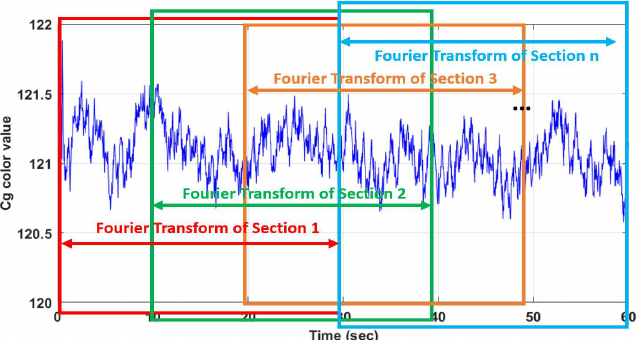
Figure 12. Separation of the Cg signal sections.